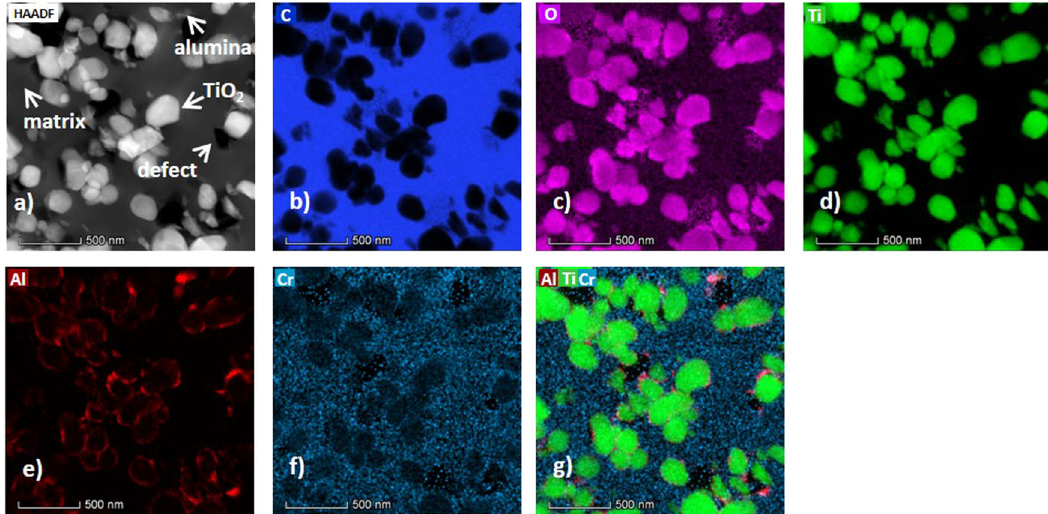
Fig. 3 STEM/EDS analysis of 30TiO 2 fi lm after exposure to Na 2 CrO 4 solution in water/acetone for 24 h at 60 °C. a STEM lamella of 30TiO 2 fi lm after exposure to Na – f Distribution of C, O, Ti, Al, and Cr, respectively. g Overlay of the 2 CrO 4 solution in water/acetone for 24 h at 60 °C. b distribution of Al, Ti, and